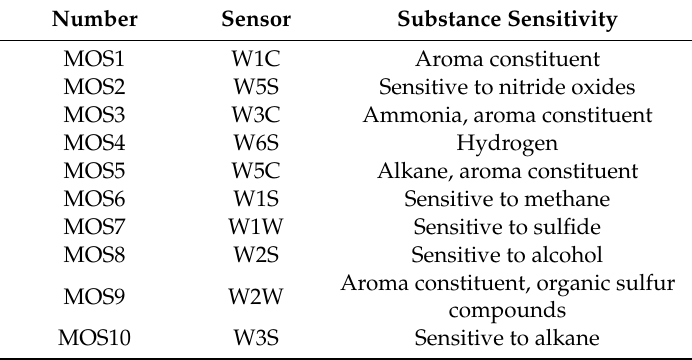
Table 2. The sensor array of the PEN3 electronic nose